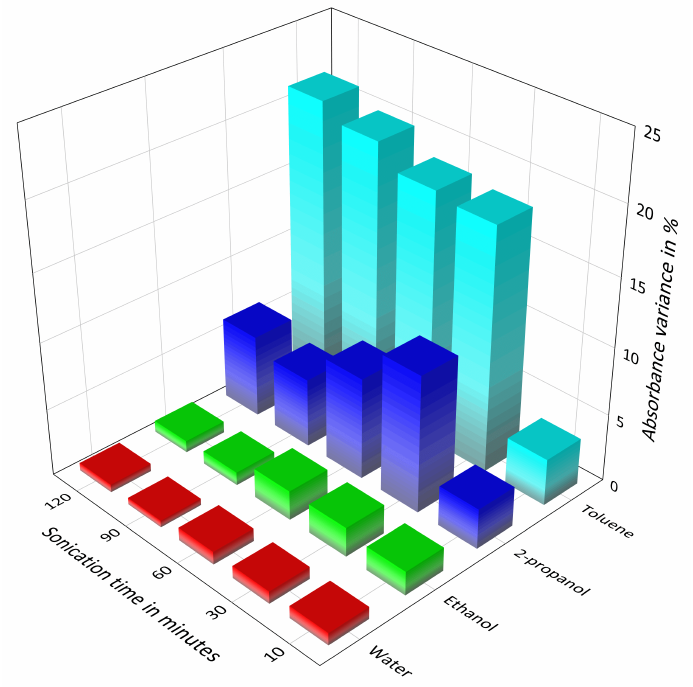
Figure 5. Dispersion stability of fMWCNT in different